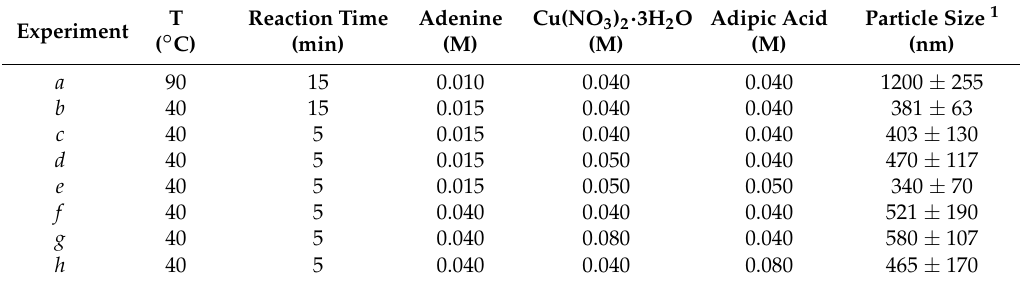
Table 1. Reaction conditions to get {[Cu 2 ( μ 3 -adeninato) 2 ( μ -Hadip) 2 ]} n and particle size at pH 5.8.